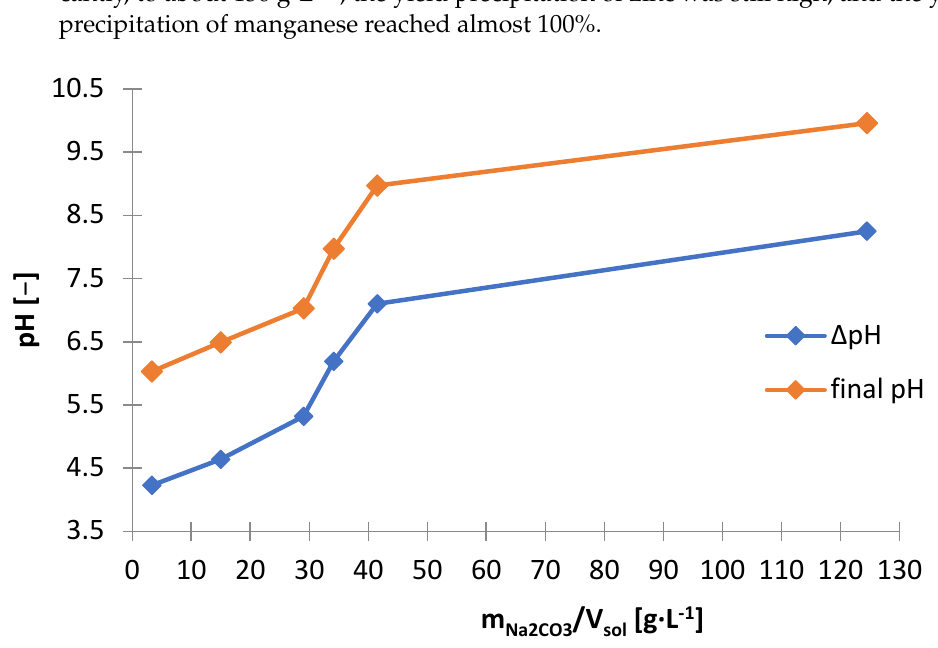
(3) pH 9–10—the Na 2 CO 3 consumption and the amount of precipitate increased signifi- cantly, to about 136 g · L − 1 , the yield precipitation of zinc was still high, and the yield precipitation of manganese reached almost 100%.